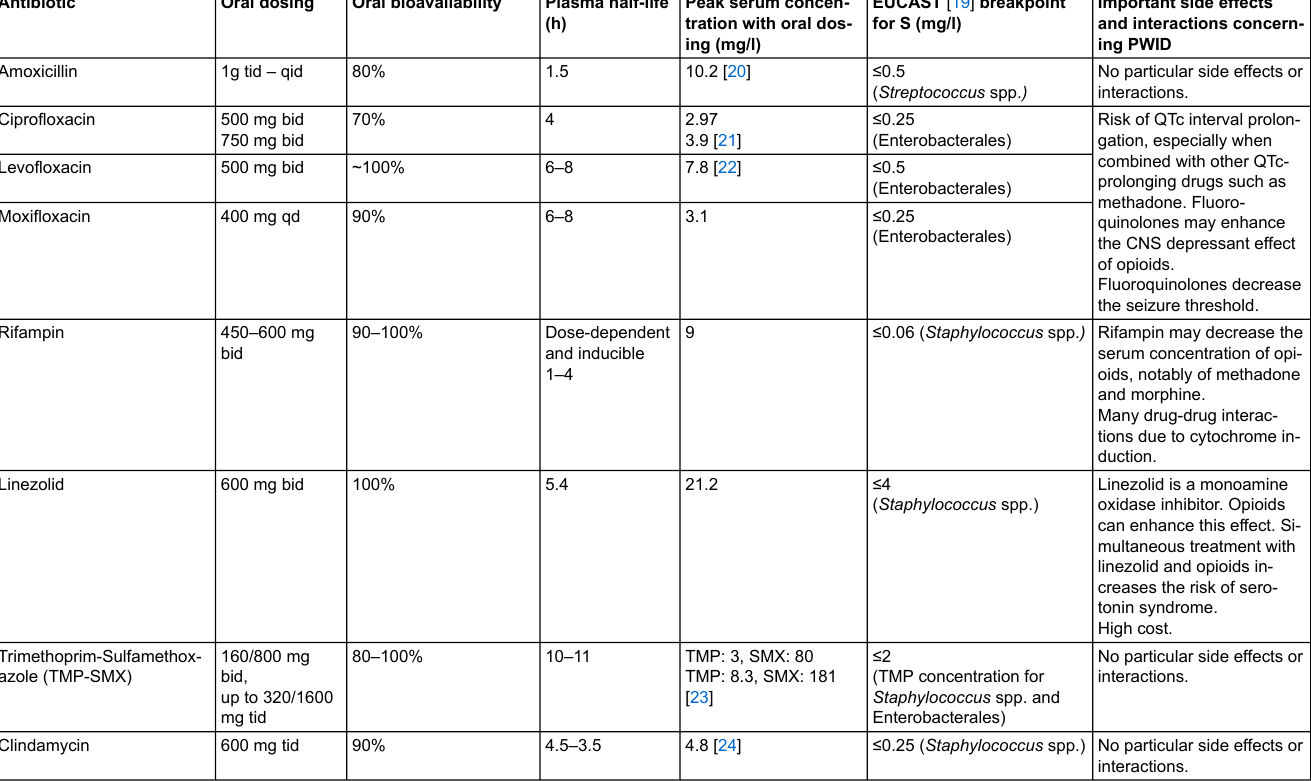
Table 2: Basic pharmacokinetic characteristics, side effects and interactions of oral antibiotics with a focus on PWID.